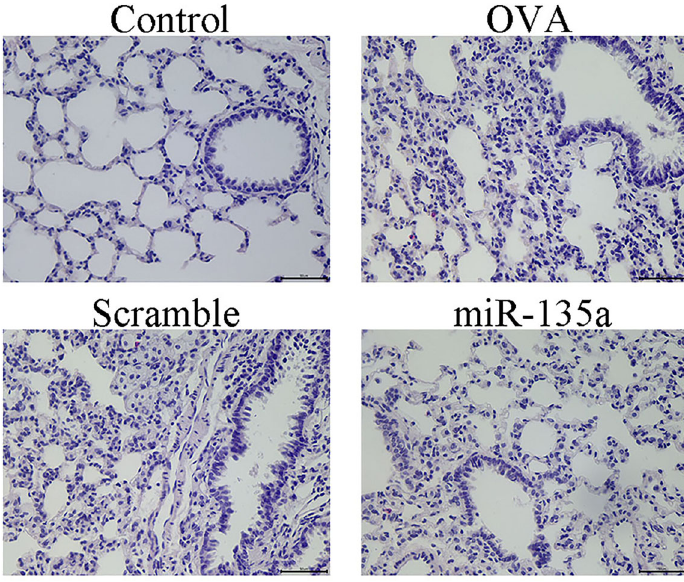
Figure 2. Effect of miR-135a on lung histopathology by HE staining in mice ( (cid:2) 400, scale bar: 50 m m).